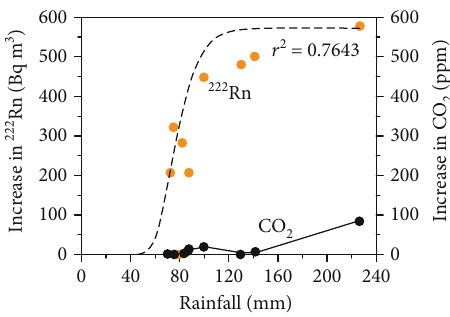
Figure 12: Variation in 222 Rn (Bq m -3 ) and CO occurs. Study period: November 2012-April 2018. 222 Rn data fi ts to a Gompertz function with a critical size threshold of